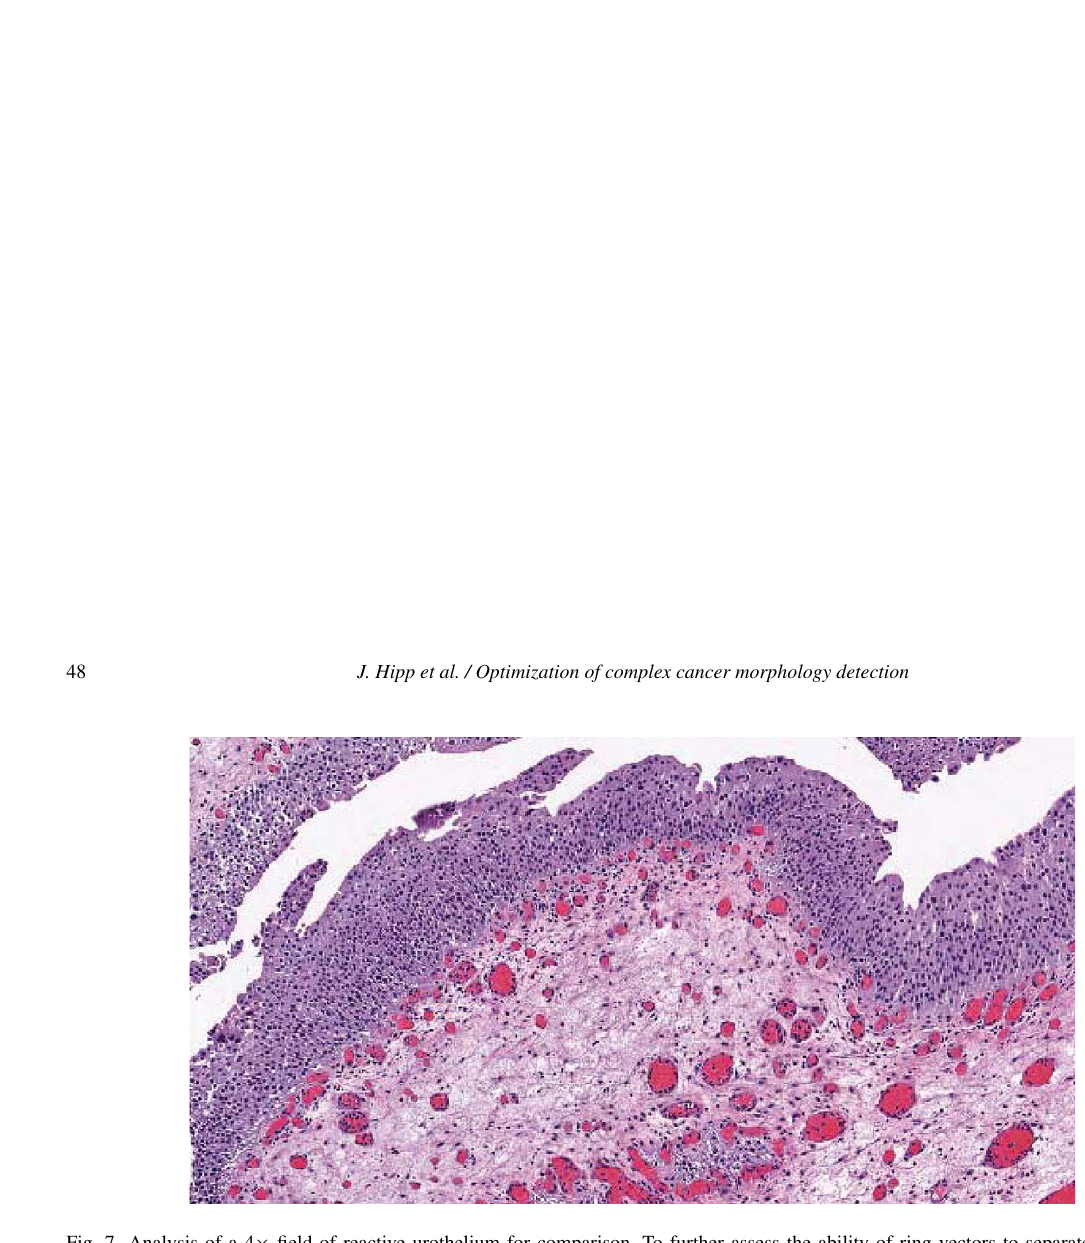
Fig. 7. Analysis of a 4 × field of reactive urothelium for comparison. To further assess the ability of ring vectors to separate MPUC from background, we employed the same ring vectors from Fig. 4 and used an additional field showing reactive, hyperplastic urothelium. This additional field of view of reactive urothelium, a benign mimicry of in situ UC, shows a slightly different stromal texture and dilated blood vessels and served as a negative control.